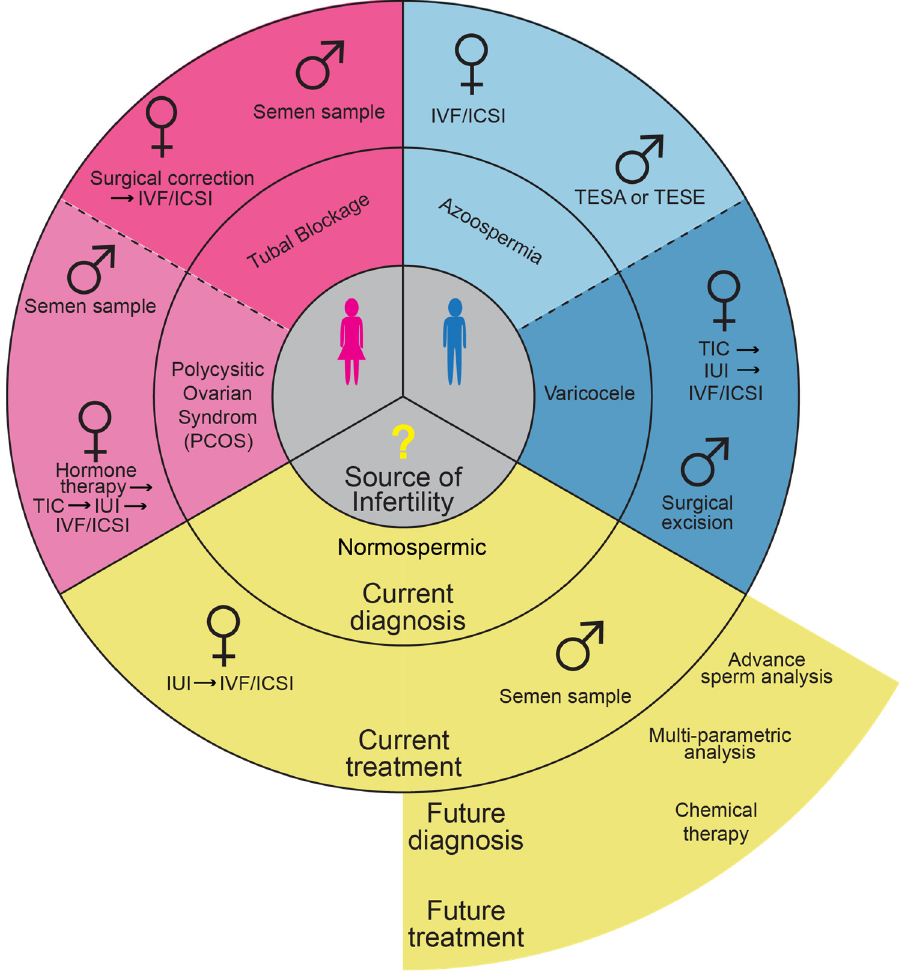
Figure 1. Examples of potential diagnoses and treatments that are biased against women. Male factor is indicated in blue; female factor is indicated in pink; unknown factor is indicated in yellow. For each of these factors we provide two examples of current diagnoses and their respective current treatment.